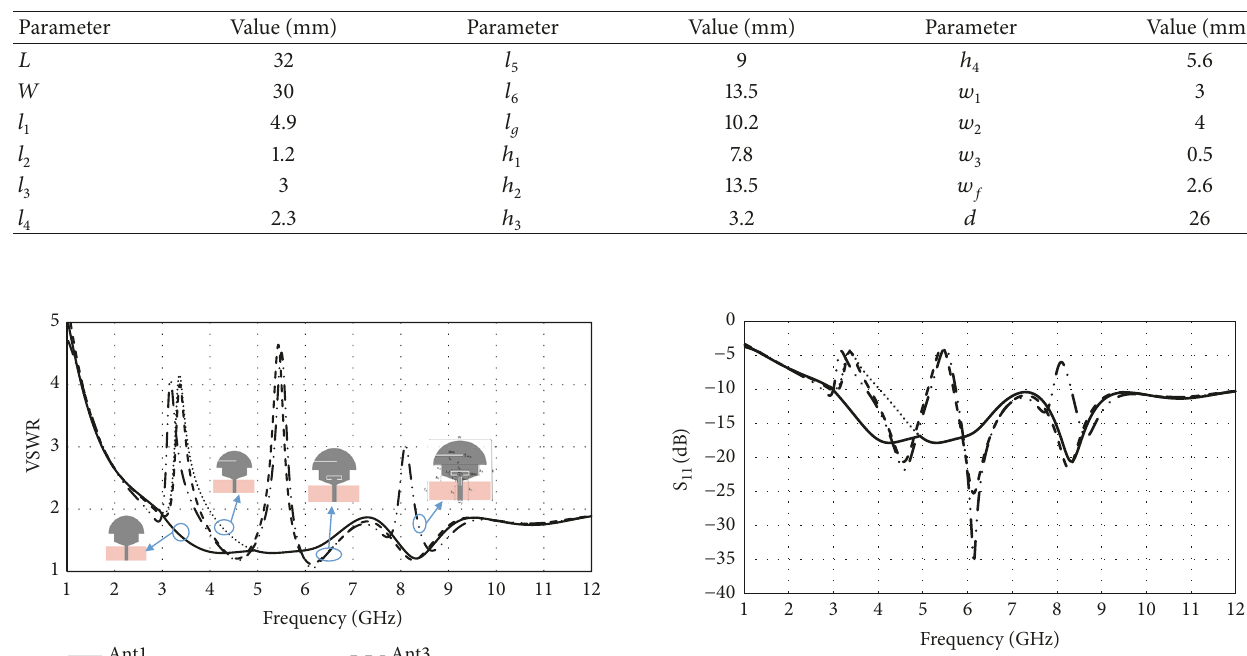
Table 2: Dimensions of the proposed UWB antenna.